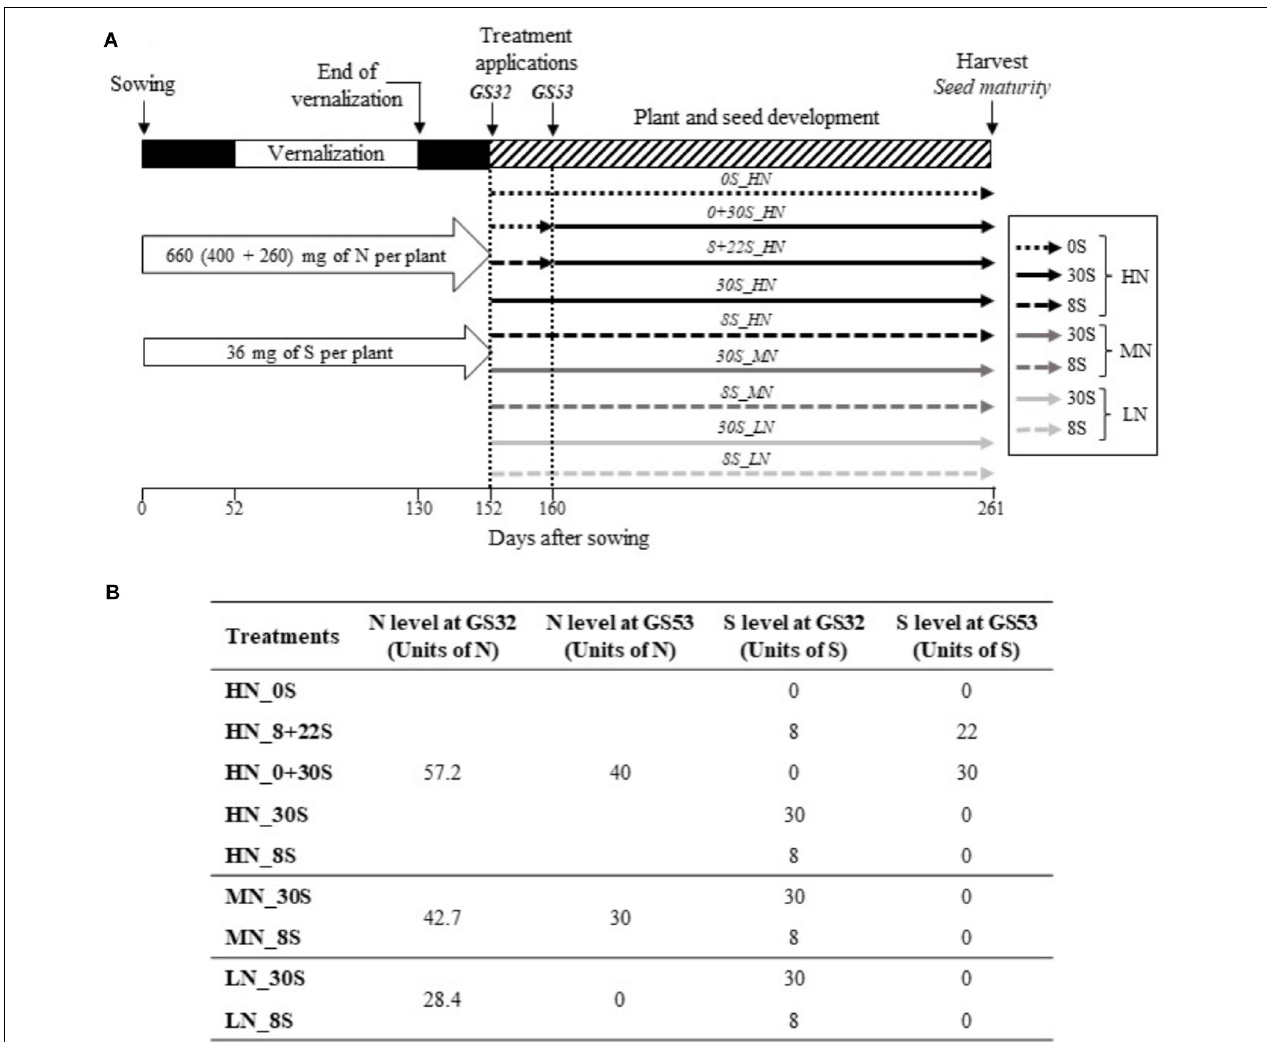
FIGURE 1 | Schematic diagram of experimental design (A) and table of the different S and N fertilization strategies (B) . Seven combinations of S and N fertilization treatments with S levels of 0 kg S ha − 1 (0S), 8 kg S ha − 1 (8S), and 30 kg S ha − 1 (30S), and N levels from 28.4 kg N ha − 1 (Low N, LN), 72.7 kg N ha − 1 (Mid N, MN), and 97.2 kg N ha − 1 (High N, HN), which were applied manually to the plants. N supplies were provided at the bolting (GS32) and early flowering stages (GS53). S supplies (30S and 8S) were provided at the GS32 stage and were included with each N condition. The 0S condition was only included with the HN condition (negative control). To investigate the impact on seed nutritional quality of delaying or fractionating S inputs, S was provided at GS32 and/or at GS53 under non-limiting N conditions (HN). The fractionated condition (8+22_HN) corresponded to a dual input of 8U and 22U of S provided at GS32 and GS53, respectively. The delayed S input (0+30S_HN) corresponded to a single input of 30 U of S provided at